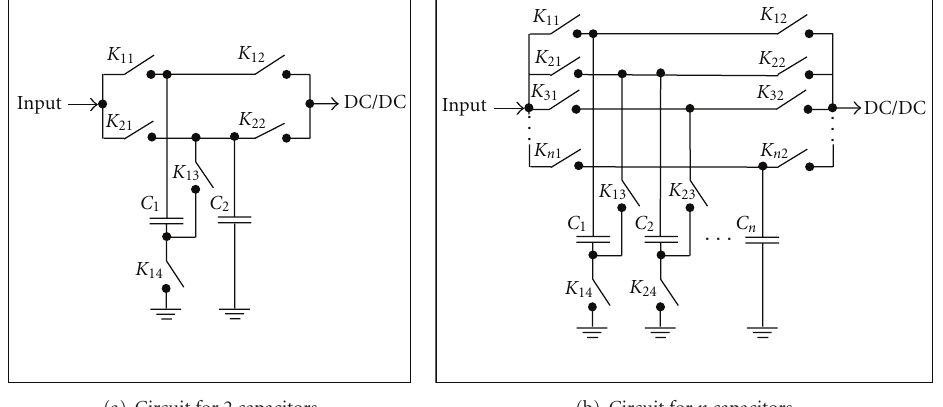
Figure 3: Capacitor array circuit.